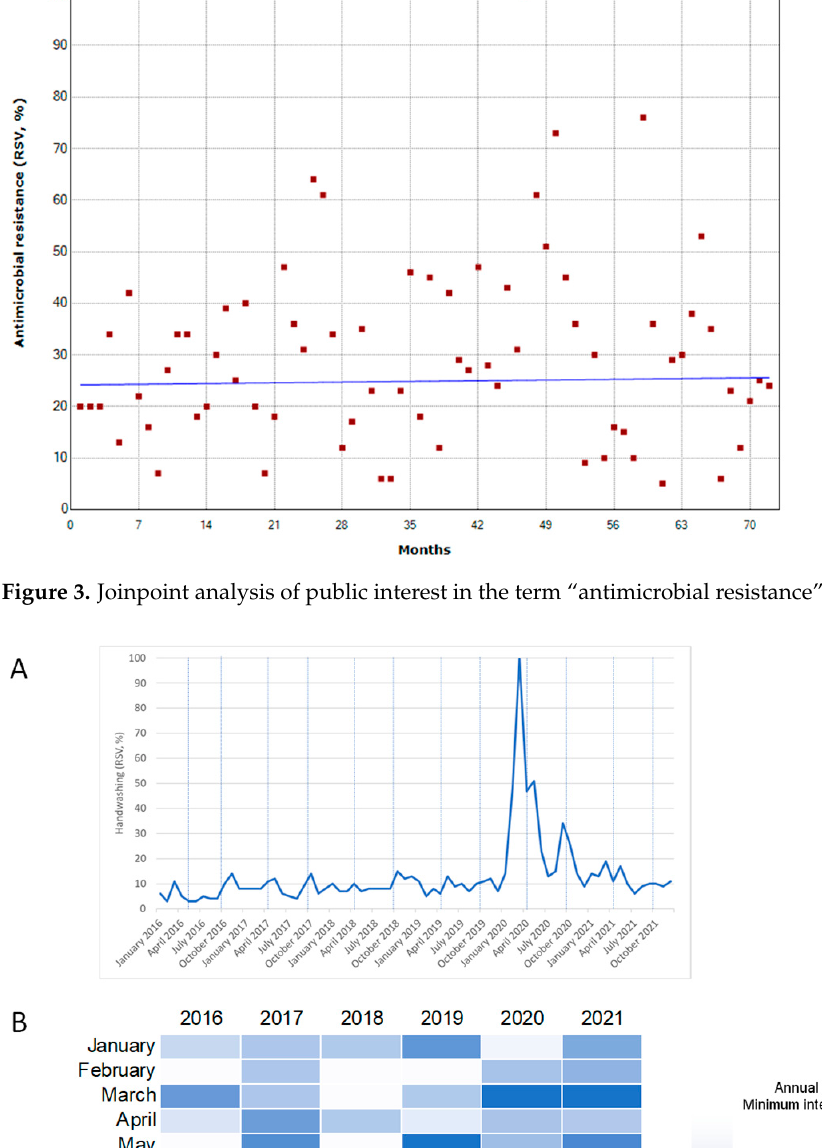
Figure 3. Joinpoint analysis of public interest in the term “antimicrobial resistance”.